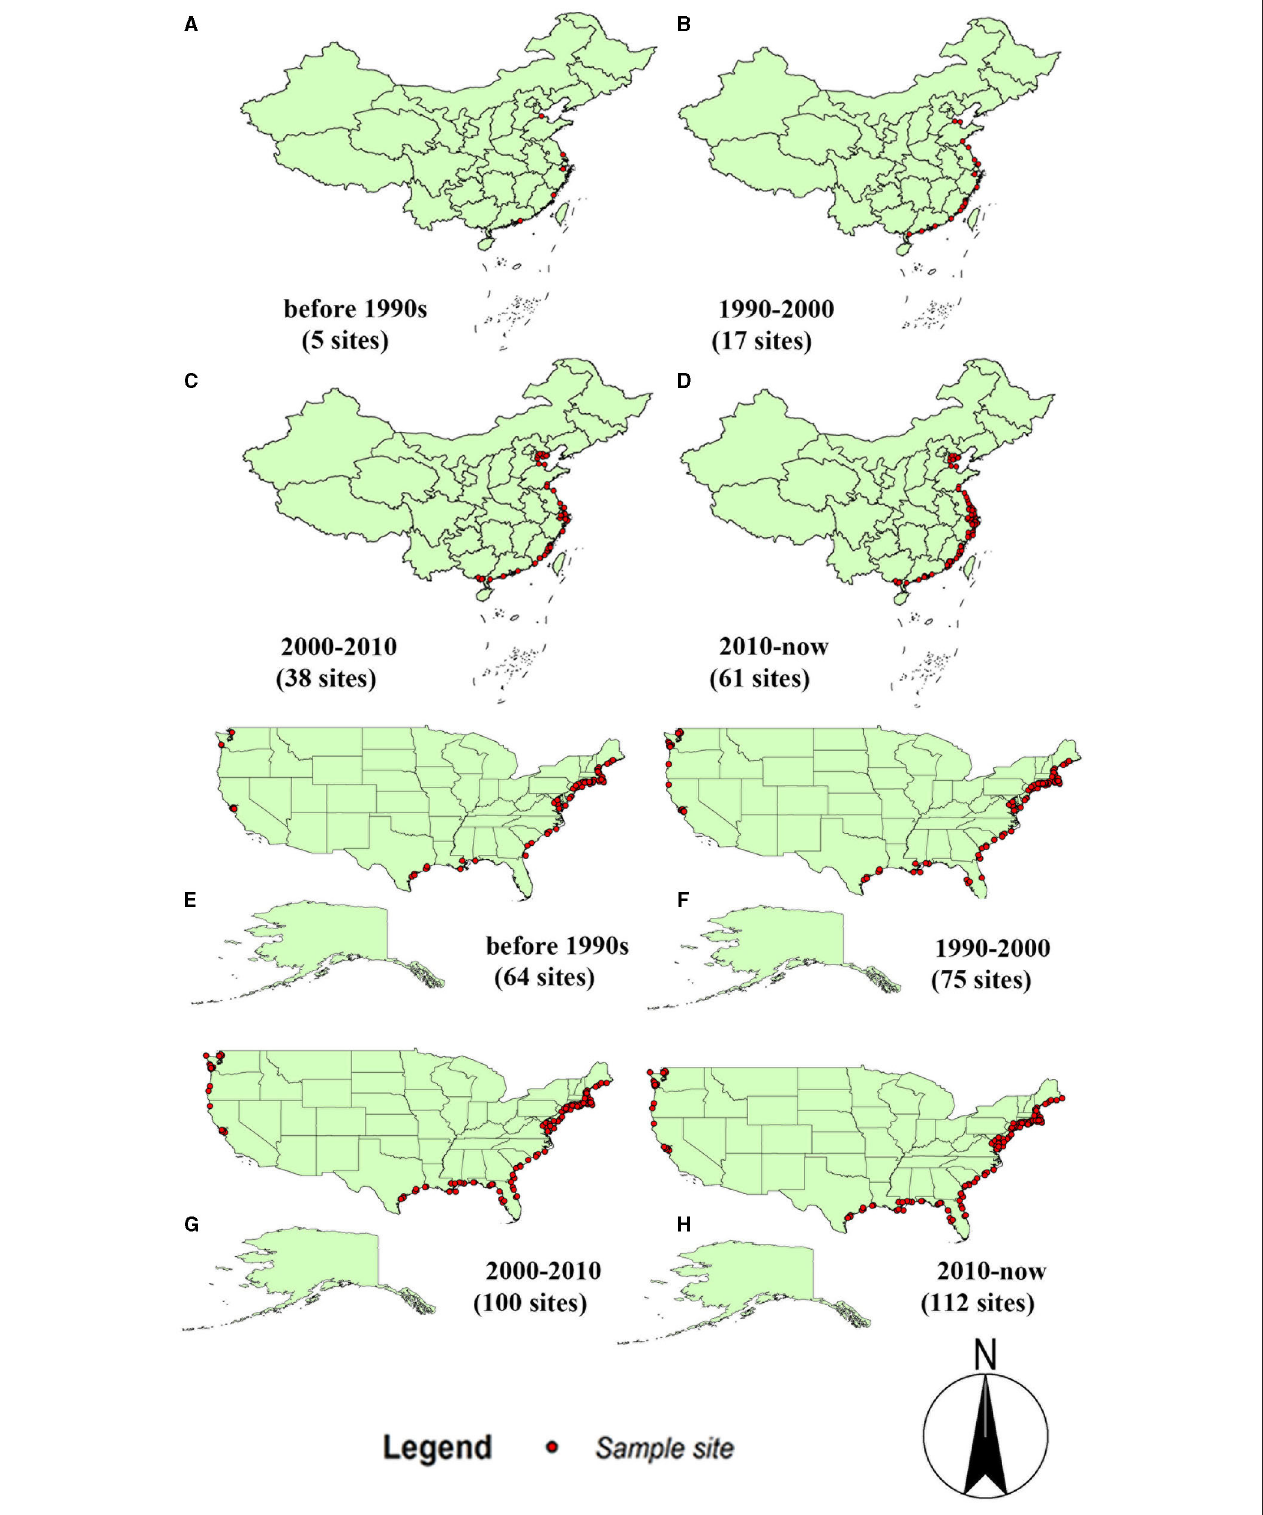
FIGURE 1 | The dynamic map of Spartina alterniflora in China and America. (A) Before the 1990s in China; (B) 1990–2000 in China; (C) 2000–2010 in China; (D) 2010–now in China; (E) before the 1990s in America; (F) 1990–2000 in America; (G) 2000–2010 in America; (H) 2010–now in America.